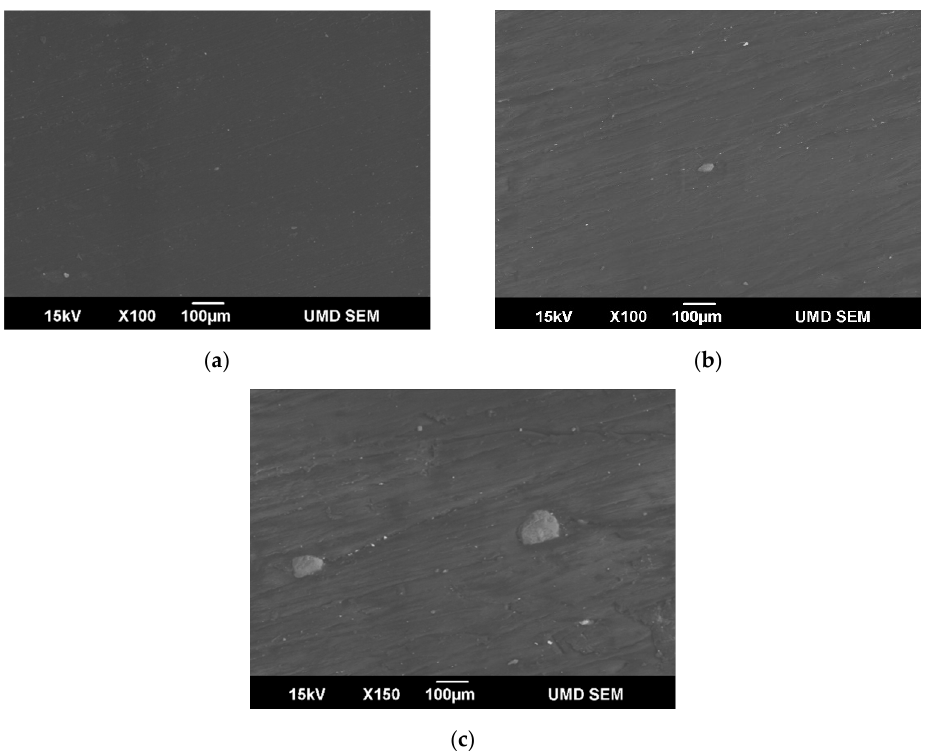
Figure 10. SEM Micrographs of ( a ) 5%, ( b ) 15% and ( c ) 30% PP-Lignin blends.